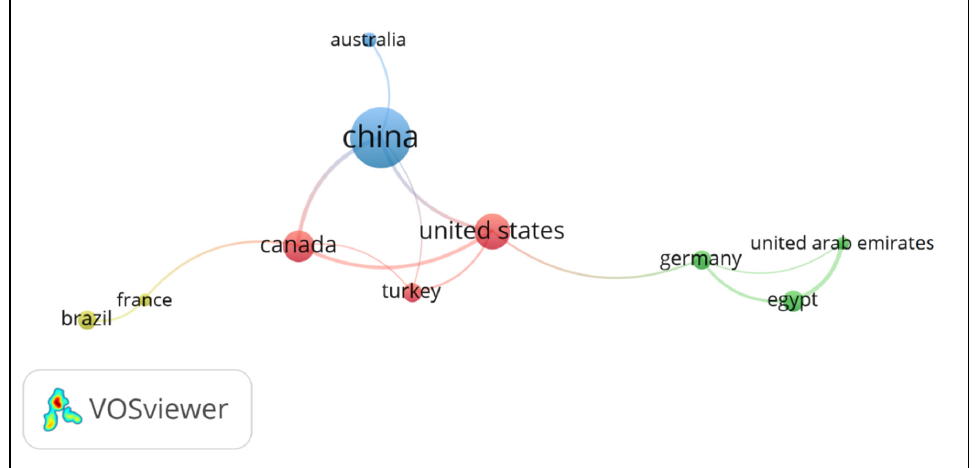
Figure 7. Most contributing countries in the LBAs research. Table 4 organizes the most relevant countries numerically and complements the in- formation presented in Figure 7. Japan, Lithuania, Norway, Spain, and India do not ap- pear on the network map. These countries had a total link strength equal to 0, which means that their collaborating countries did not comply with the restrictions adopted. Table 4. Statistical analysis of productive countries in LBAs research. No. of Country Articles